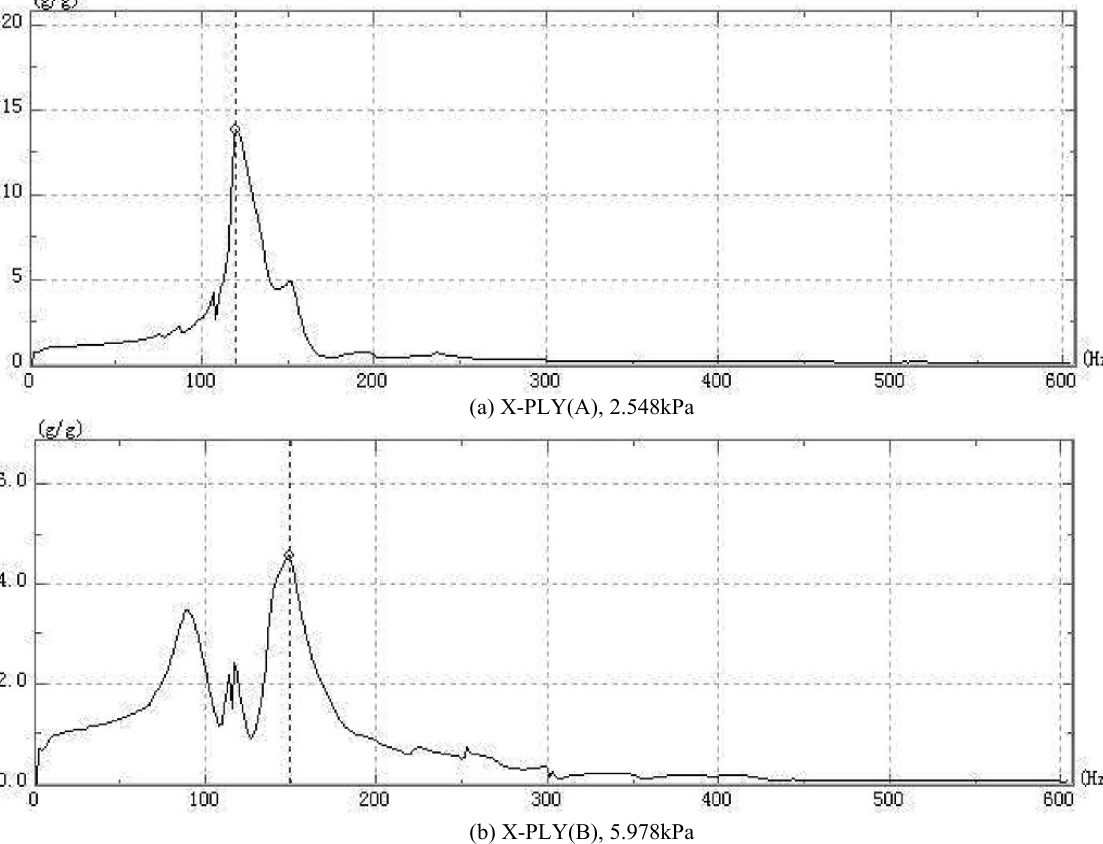
Fig. 7. Vibration transmissibility and frequency